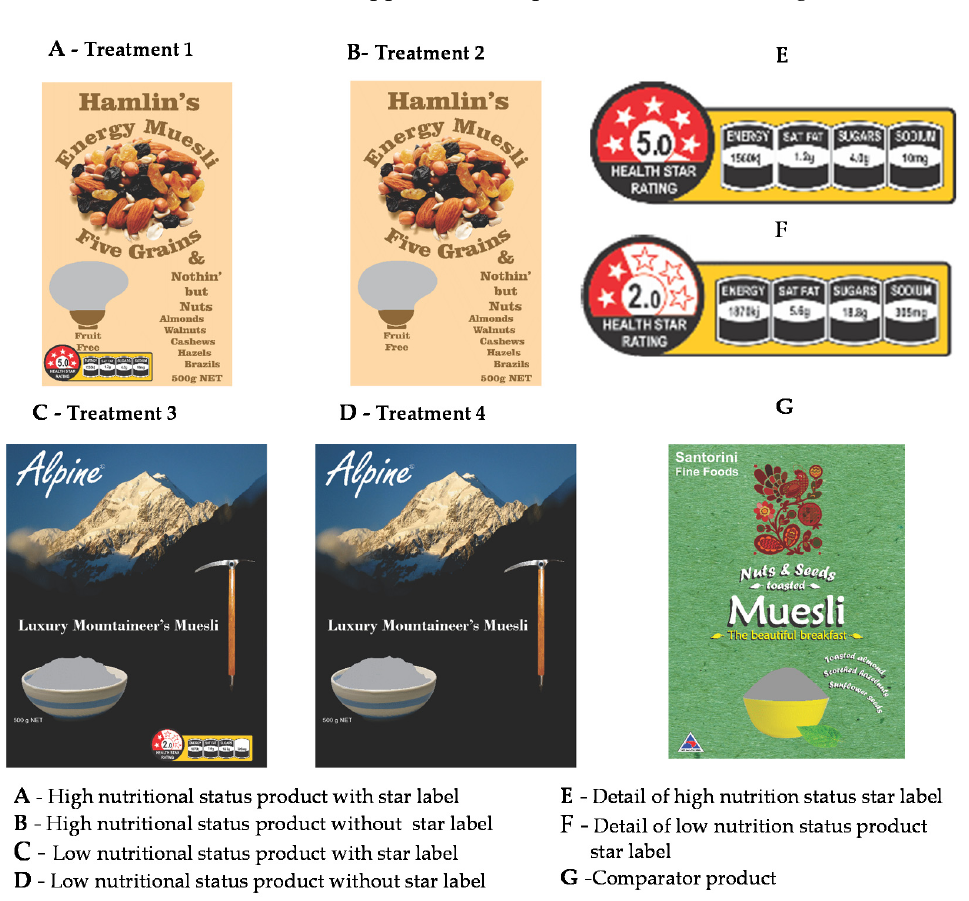
Figure 5. Front facings of the treatments used, comparator product and HSR FOP labels.